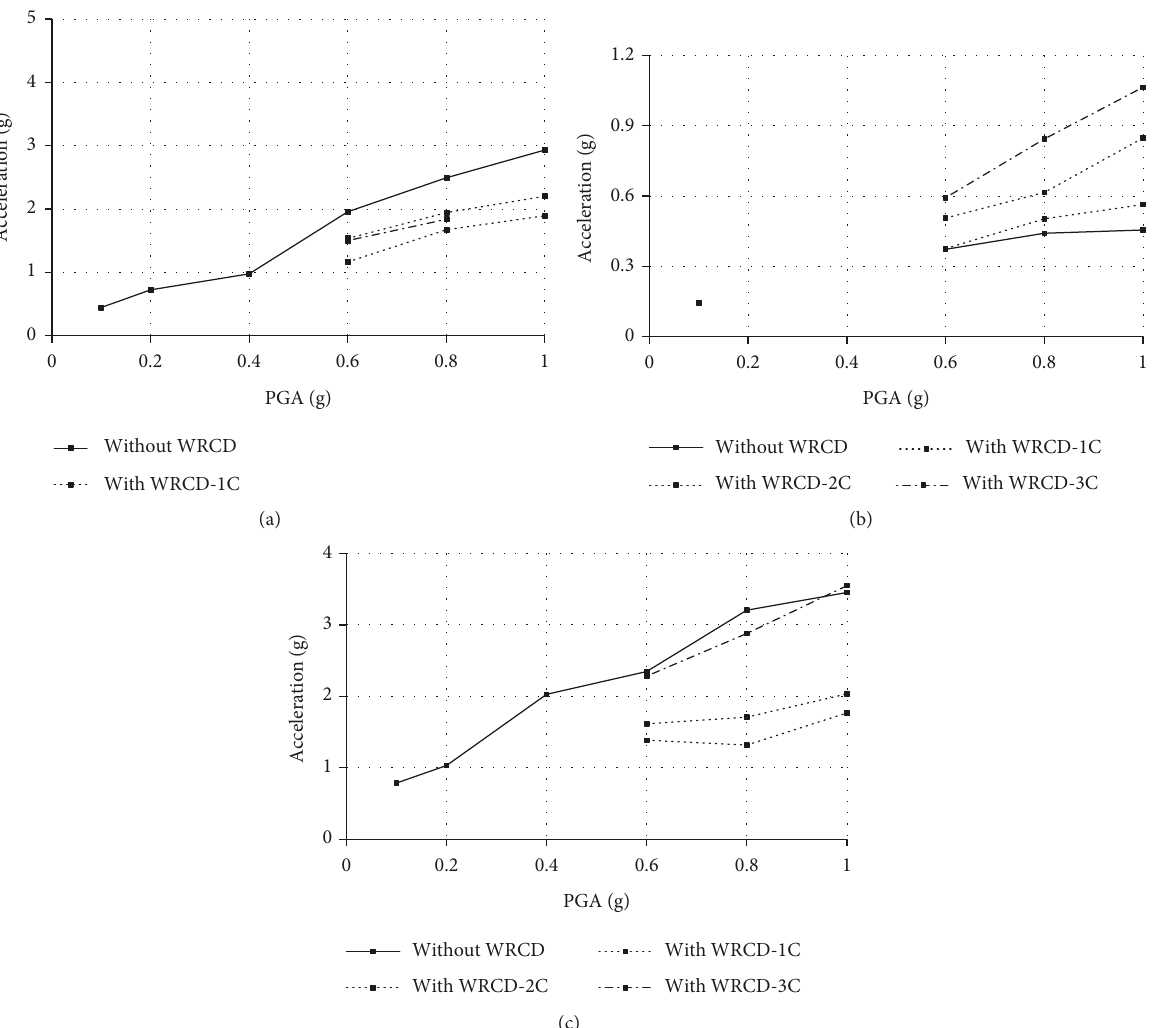
Figure 8: Acceleration variation trend with seismic input intensity under Tianjin ground motion. (a) Top of movable pier #1. (b) The main beam of pier #2. (c) Top of movable pier